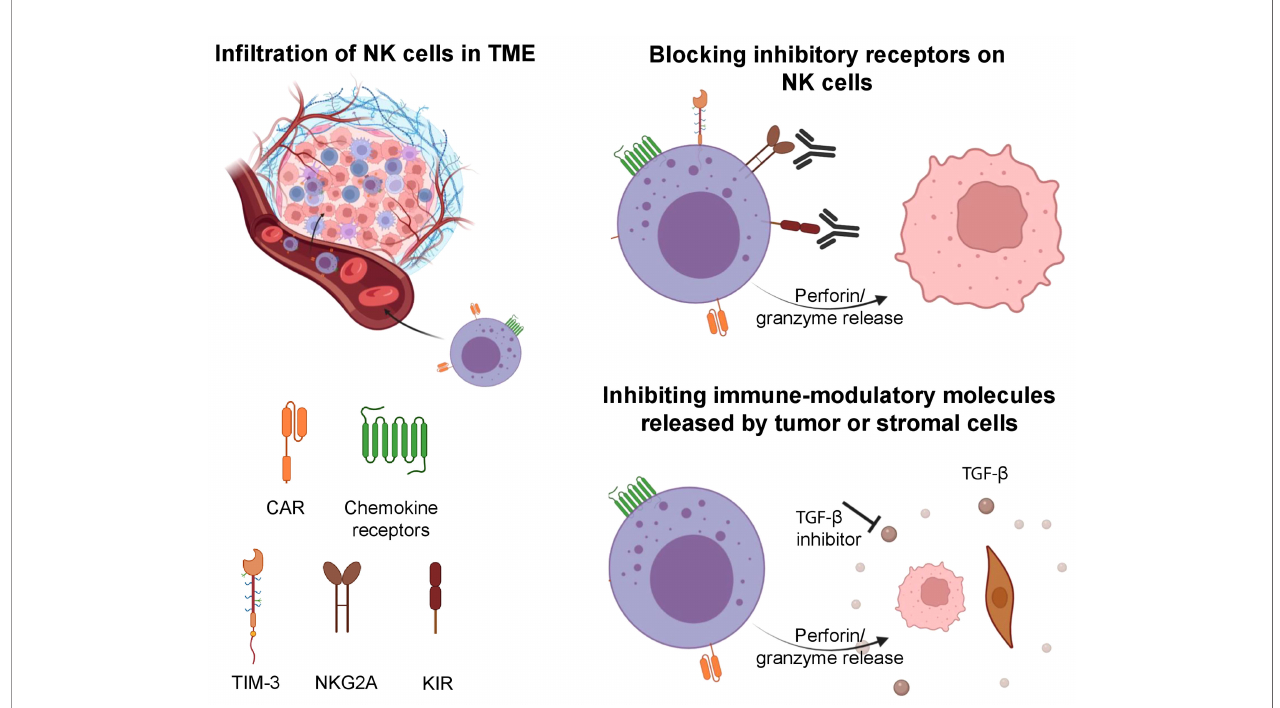
FIGURE 2 | Strategies involved to improve the tumor in fi ltration of NK cells, overcome tumor escape and exhaustion. NK cells can be engineered to express CAR and speci fi c chemokine receptors to increase their in fi ltration in solid tumors. Upon entry into the TME, NK cells can be impaired by its immune suppressive features. Blockade of inhibitory receptors (TIM-3, NKG2A, KIR) on NK cells can increase their antitumor cytotoxicity. Further, inhibition of immune-modulatory molecules (TGF- b ) can prevent exhaustion in NK cells and maintain their cytotoxic features. Illustration created using